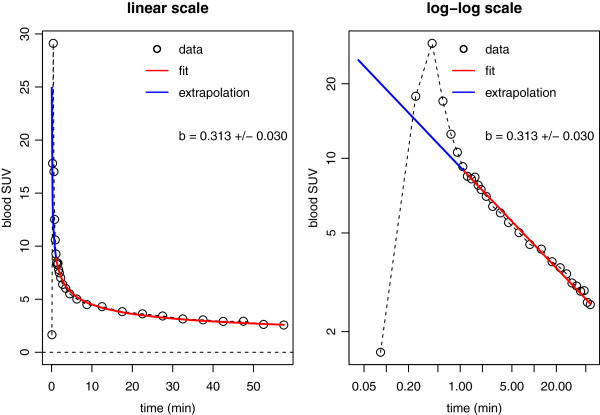
Least squares fit of hyperbola (Equation 5) to group-averaged AIF. The fit is shown in linear scale (left) as well as in double logarithmic scale (right). The specified uncertainty of the time exponent b is the standard deviation of this parameter when fitting the model separately to each of the 15 contributing AIFs which indicates the observed inter-individual variability. The data range indicated in red is used for the fit. The blue line extrapolates the fitted hyperbola to early times. Despite the obvious deviation of the hyperbola from the data in this time range, contribution to total AUC is small, and the residual difference negligible if AUC up to times t>20 min is considered.